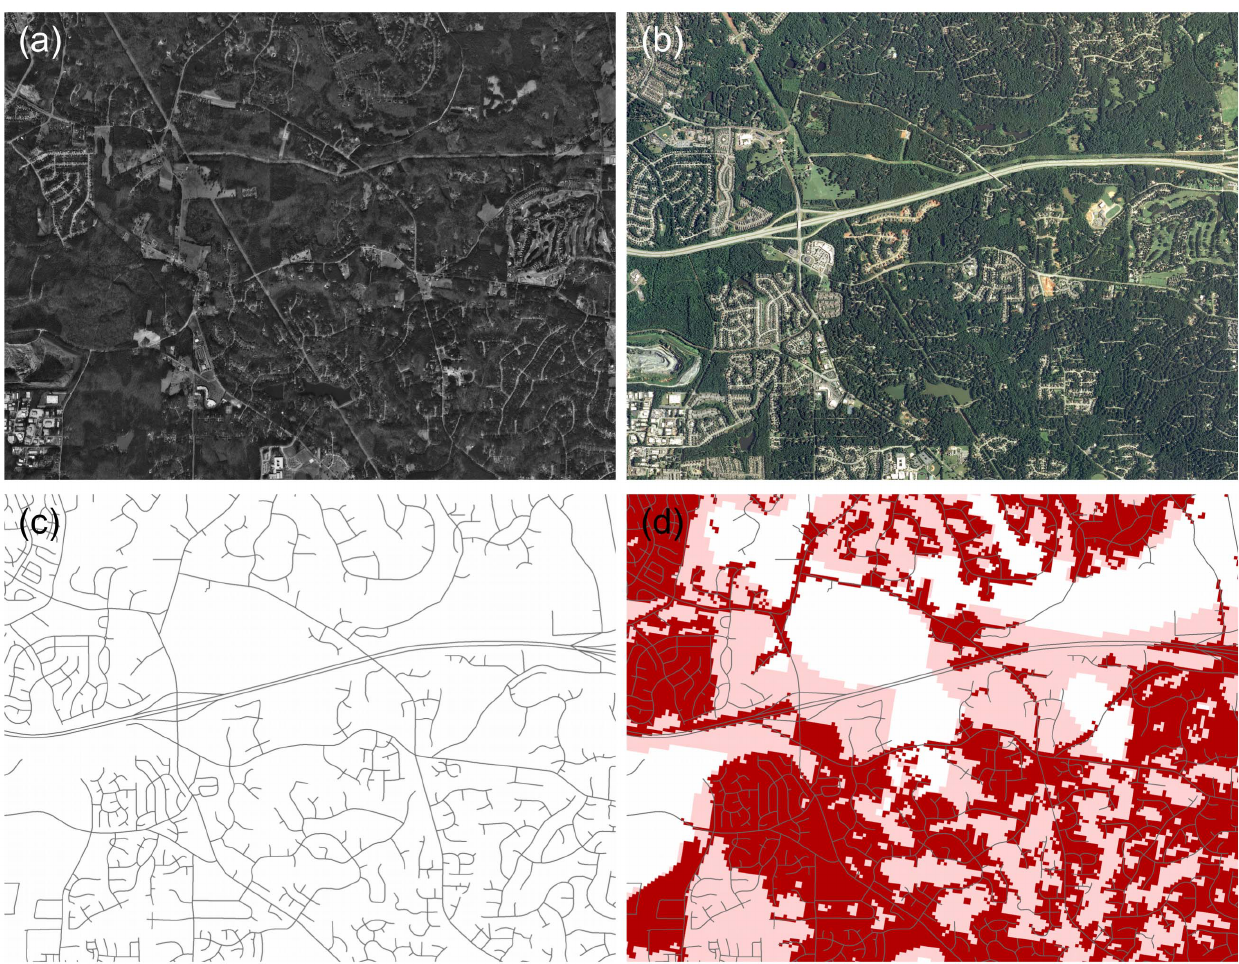
Figure 2. Urban sprawl examples and their representation in the input data. Imagery in (a) and (b) document the rapid but low-density urbanization common in the Southeast US (imagery for Raleigh, NC in 1993 and 2010). (c) Road network used as basis for identifying urban areas (same area as in (a) and (b)). (d) Initial (2009) urban classification (pink shade) based on road network density and NLCD urban classification (red shade).